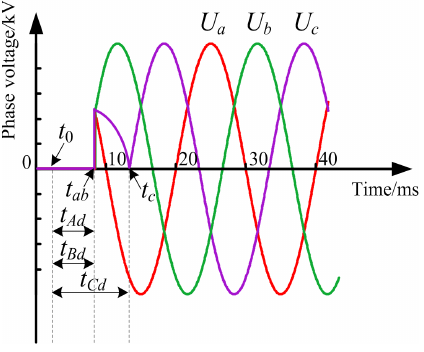
Figure 4. Sequence of closing capacitor banks with phase selection.